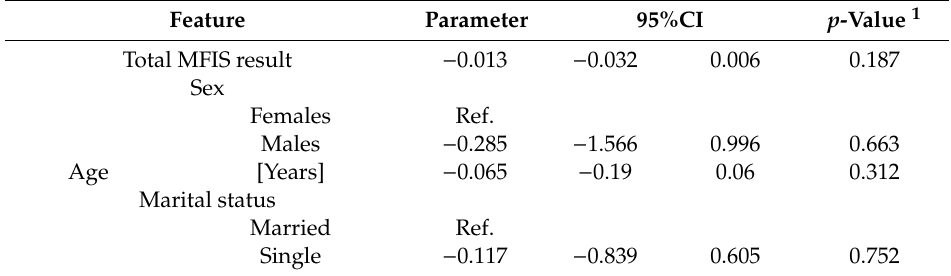
Table 5. The regression model and assessment of the quality of patient care.